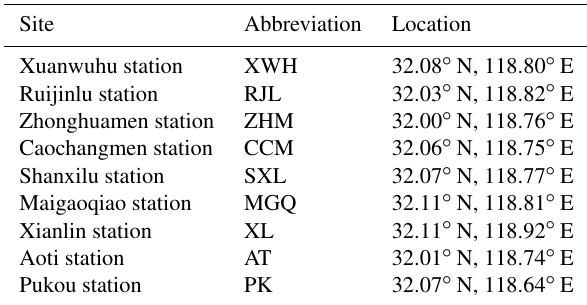
Table 1. The air-monitoring sites in